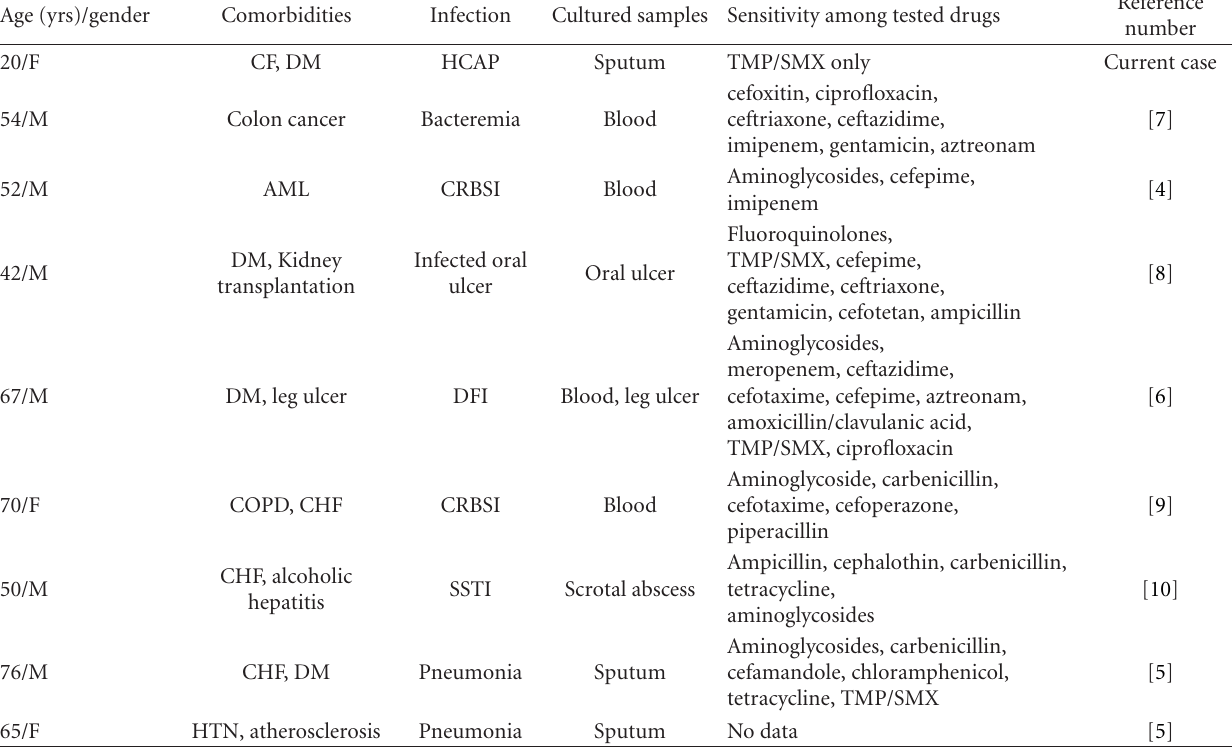
Table 1: Reported cases of C. davisae